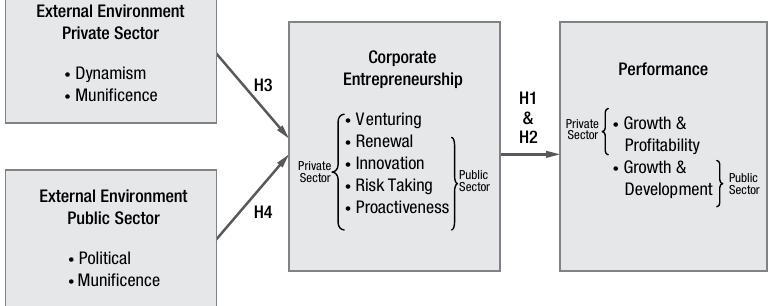
Fig. 1. Private and public sector corporate entrepreneurship